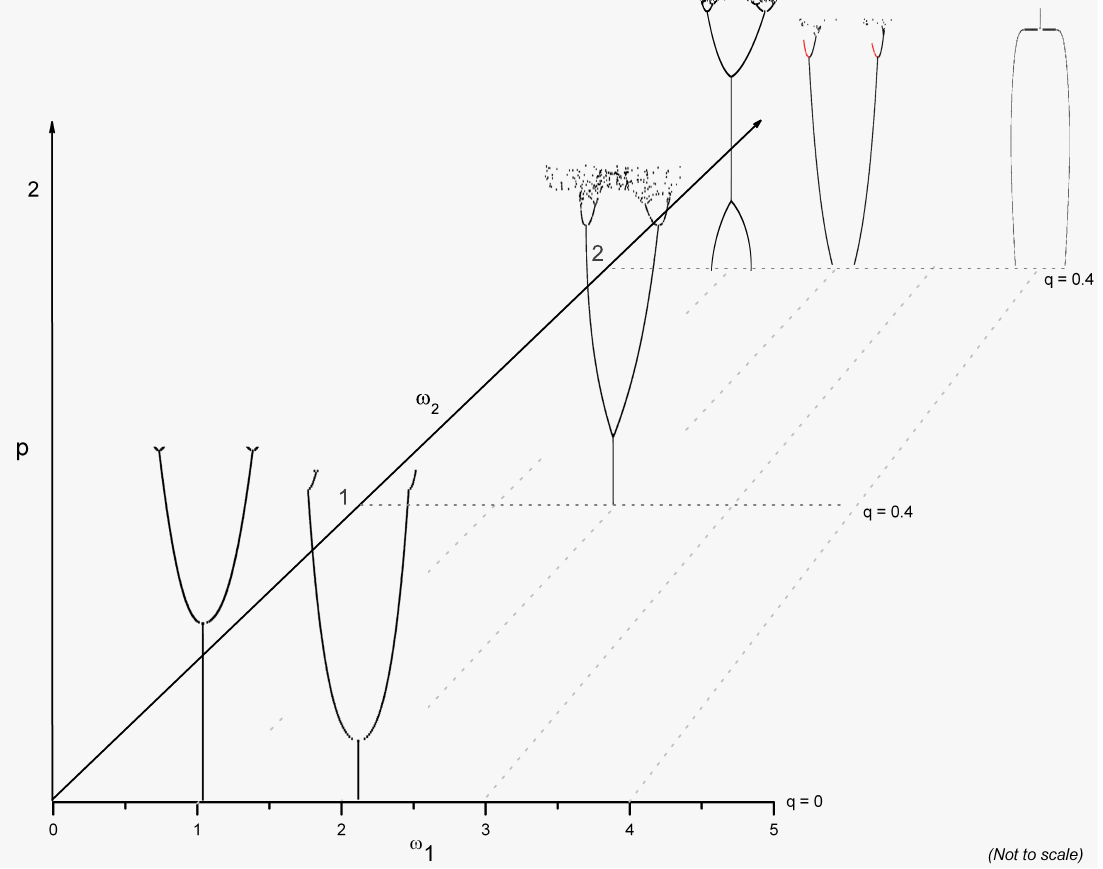
= 0 . 1 , β = 0 . 2 , ω = 1 . The 1 2 0